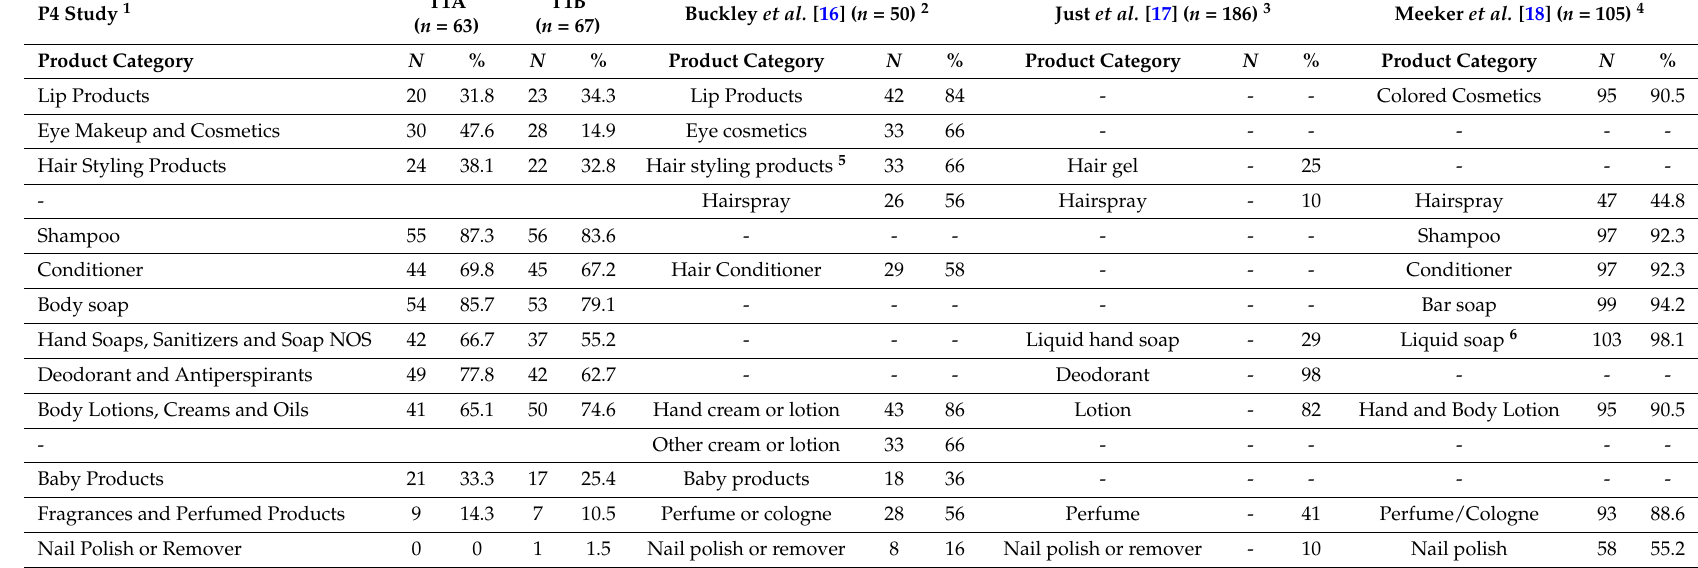
Table 4. Comparison of PCP prevalence in four studies of pregnant populations. The number and percentage of users in each study are